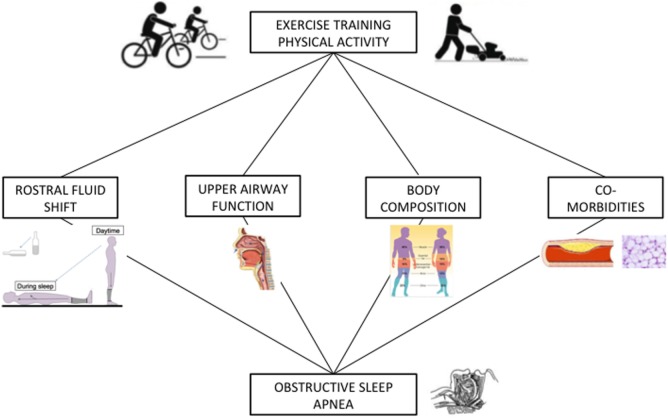
Hypothetical relationship between exercise training/physical activity and obstructive sleep apnea (OSA). The rostral fluid shift contributes to the pathogenesis of OSA and its attenuation via physical activity (47) and exercise training has been shown to alleviate OSA. The strength and fatigability of the upper airway dilators have been shown to be altered in patients with OSA. Specific exercise training modalities may improve upper airway function in OSA patients and thus contribute to decrease OSA severity. An elevated body mass index (BMI) is a key risk factor for the development of OSA while sleep disturbances can influence body composition. Exercise training has been shown to favorably modify body composition (increase lean mass, decrease fat mass) and can reduce BMI, therefore potentially alleviating the severity OSA. OSA is often accompanied by cardiovascular and metabolic co-morbidities, which can impair exercise tolerance. Exercise training has been shown to be beneficial for the improvement of a number of these co-morbidities (hypertension, dyslipidemia, type 2 diabetes, etc.).